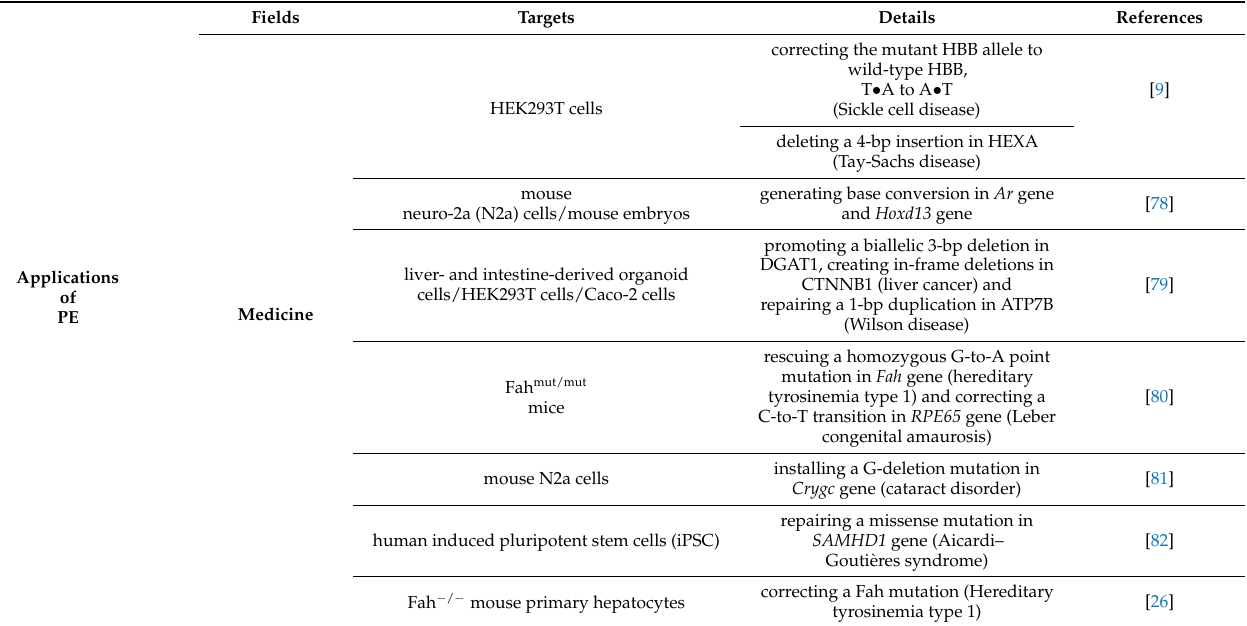
Table 3. An overview of some representative PE